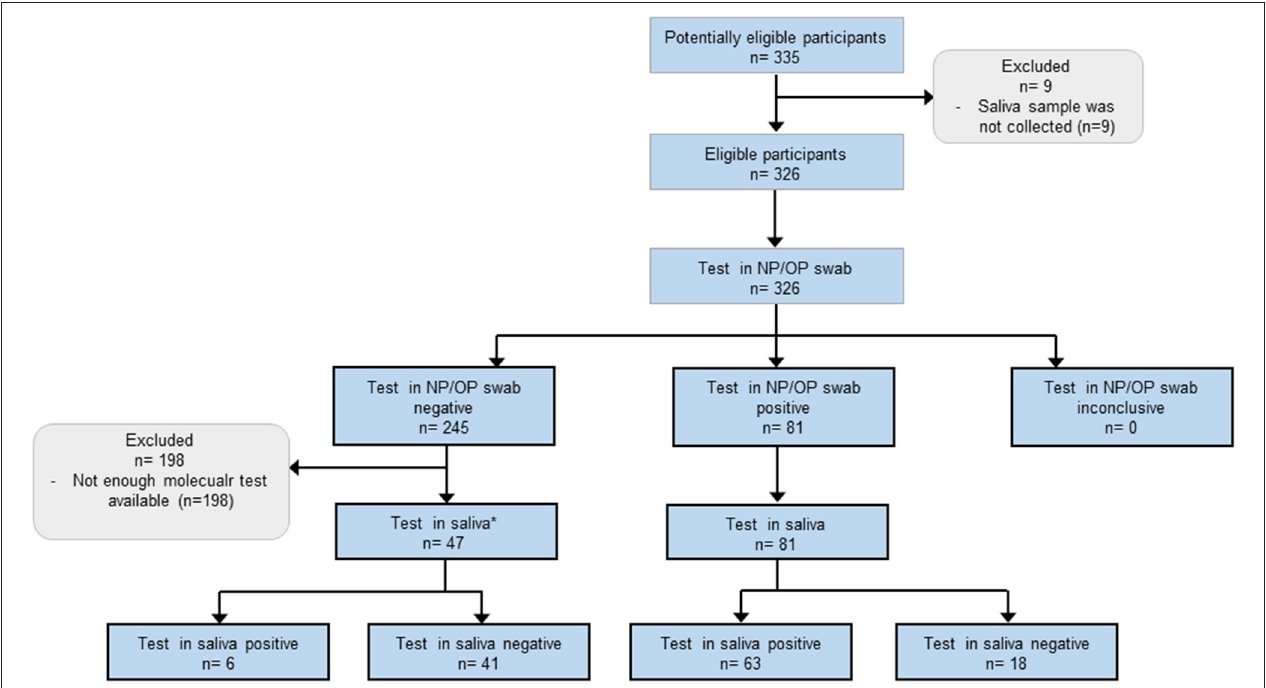
FIGURE 3 | Flow of adult participants members of the hospital staff. *Due to shortage of molecular test, only 47 saliva samples were selected from the 245 participants who tested negative in the NP/OP swab. Selected samples were those from participants with higher possibilities to be infected with SARS-CoV-2: 30 participants who showed symptoms associated with COVID-19, and 17 participants in which the Ct values of the NP/OP swab analysis were just above 40, this value was the threshold for positivity. The characteristics of these participants are shown in Tables 4 , 5